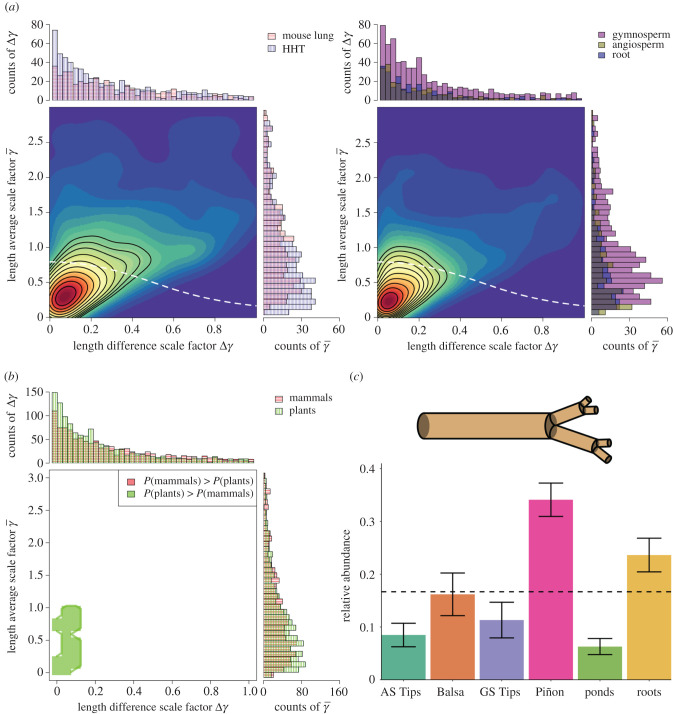
Classification based on features (the length-scale factors γ¯ and Δγ) that are related to costs of materials and construction for these networks as well as the extent to which they fill the space of the organisms that they are supplying with nutrients and resources. (a–c) See caption for figure 3 for description of subfigures. The significance-region abundances in (c) are corroborated with global-level testing of all pairs of branching networks (see electronic supplementary material, table S3).